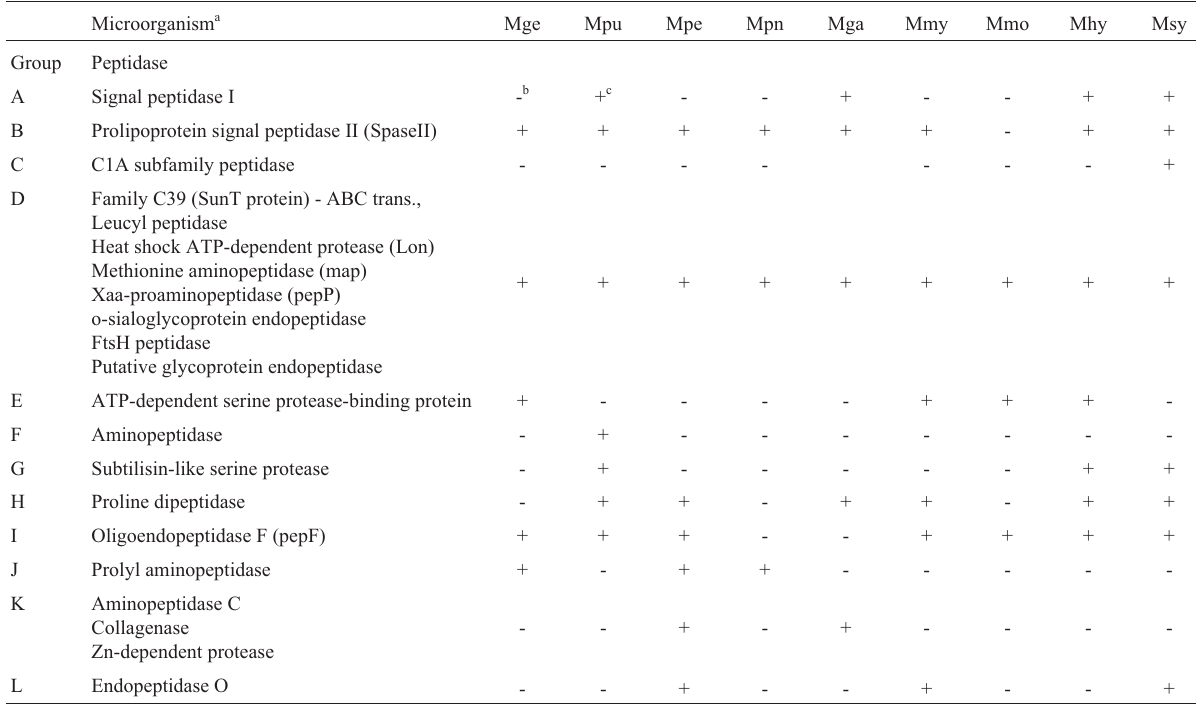
Table 2 - Distribution of putative proteases in mycoplasmas. Microorganism